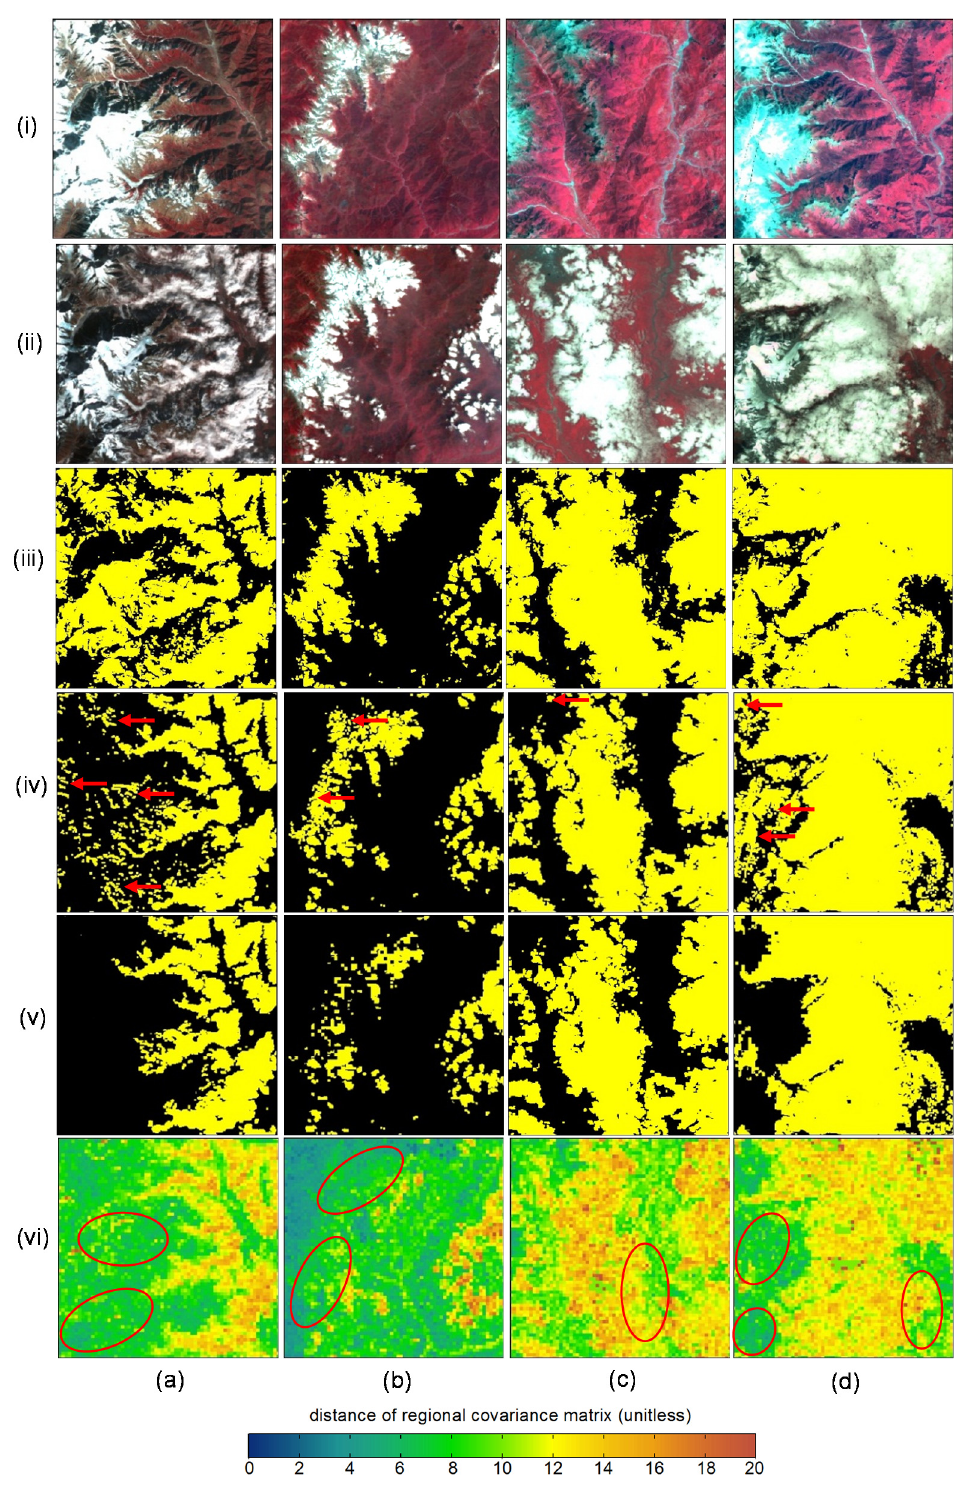
Figure 9. The comparison before and after using the regional covariance matrix (RCM). Column ( a – d ) are the HJ images acquired in 6 January, 30 April, 29 June and 10 October and its corresponding cloud and snow discriminating results in each stage, respectively. The first and second row are the corresponding monthly composited images and the original images shown in false color with bands 4, 3, and 2 in red , green and blue , respectively. The third, fourth and fifth rows are the cloud masks for spectral test, temporal test, and texture test, respectively. The sixth row is the distance of RCM with its color bar under the bottom of this figure.